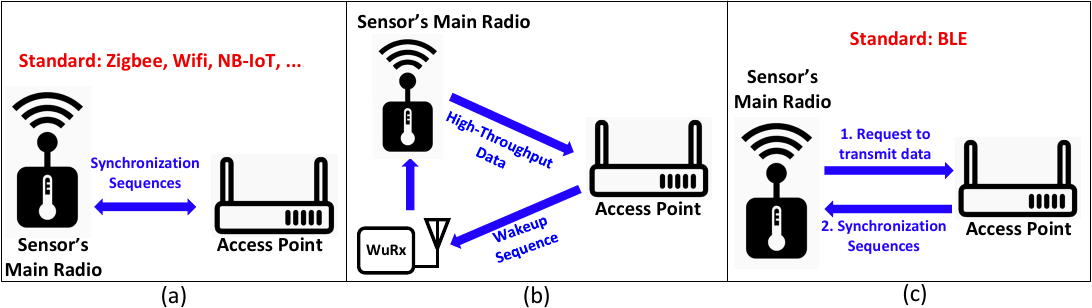
Figure 3. Different synchronization schemes resulting in different complexity and power budget requirements: ( a ) syn- chronous; ( b ) wake-up receivers; ( c ) asynchronous.